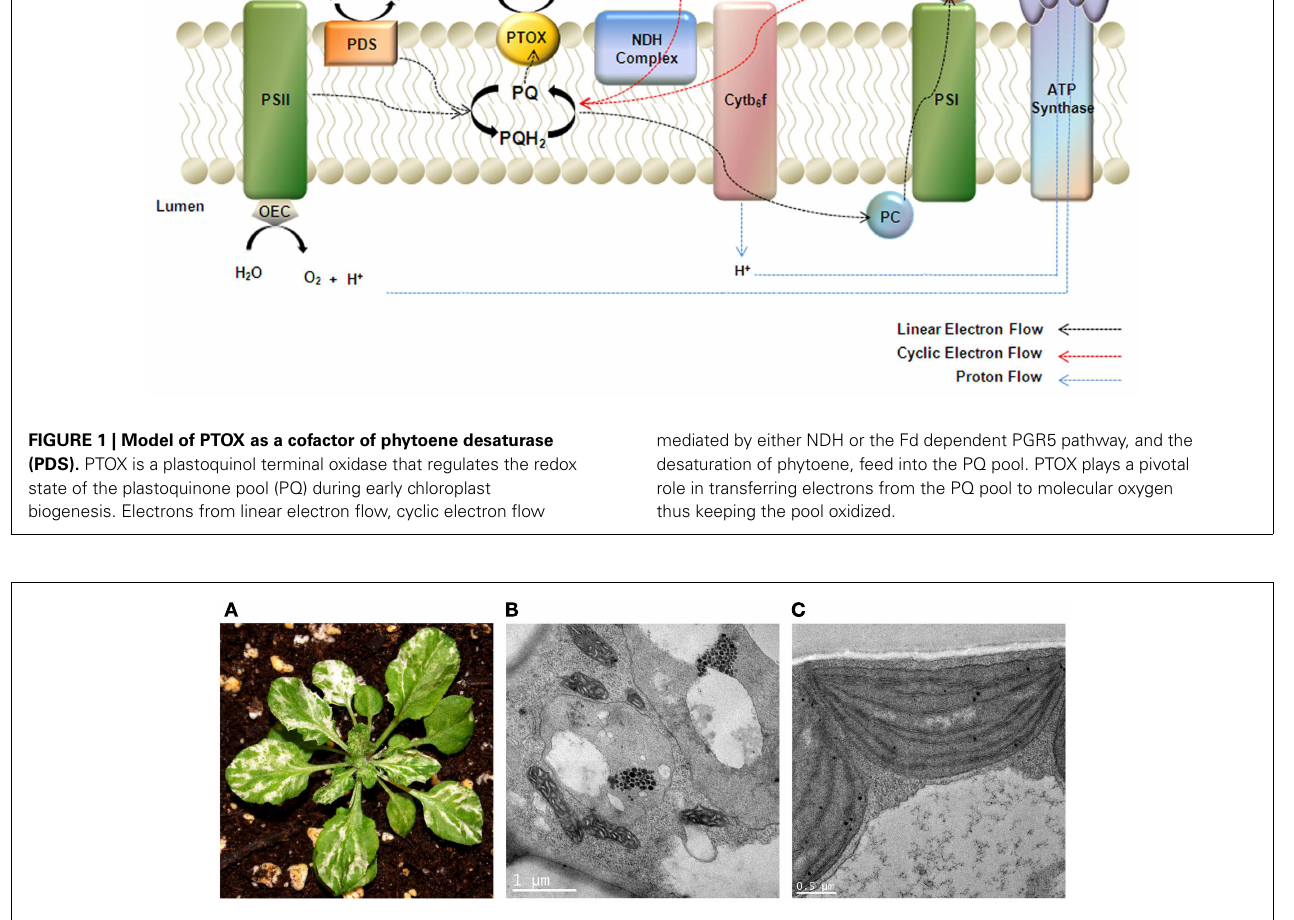
(B) Representative plastids from an im white sector.The plastids lack organized lamellar structures and contain vacuoles and numerous plastoglobules. (C) Representative chloroplast from an im green